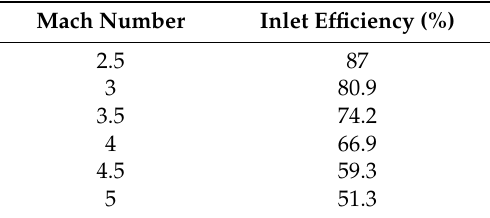
Figure 20. Performance of ramjet inlet at Mach 5.0 (50,000 ft). Table 2. Inlet efficiency at different Mach